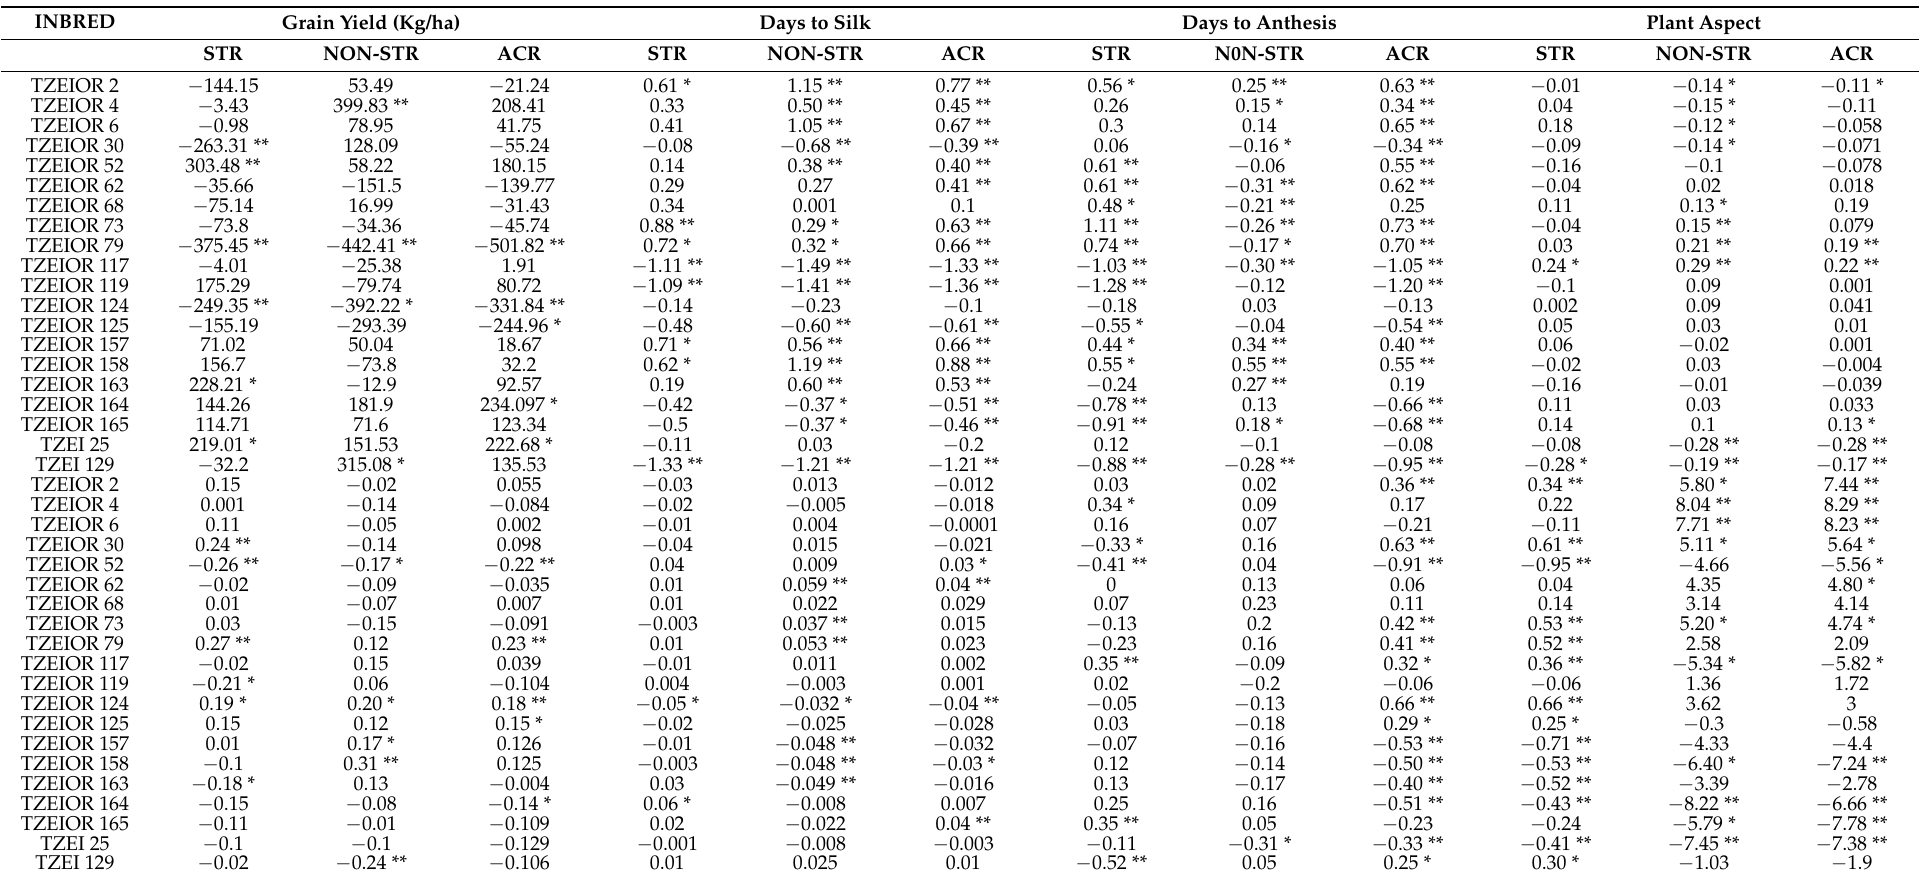
Table 4. General combining ability (GCA) effects for grain yield and other agronomic traits of the 20 early maturing pro-vitamin A inbred lines crossed in diallel fashion and evaluated under stress, non-stress and across both conditions between 2016 and 2017 in